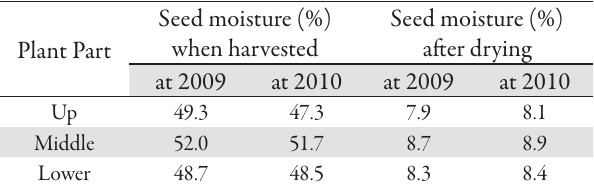
Tab. 4. Effect of different plant parts on seed moisture in 2009 and 2010